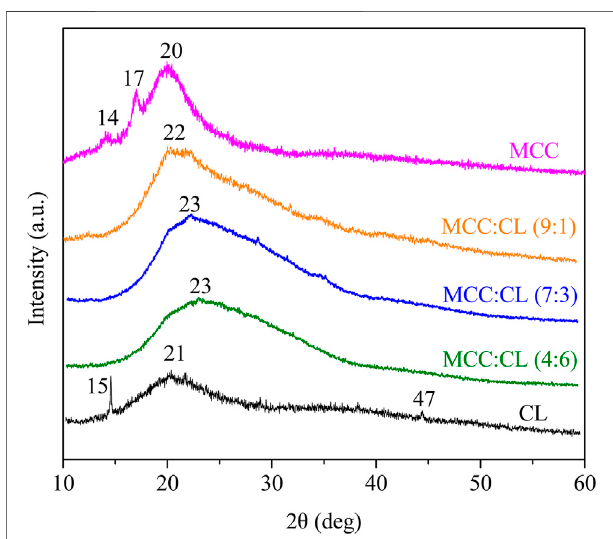
FIGURE 5 | X-ray diffraction patterns of the MCC fi lm, CL extract, and MCC:CL biocomposite fi